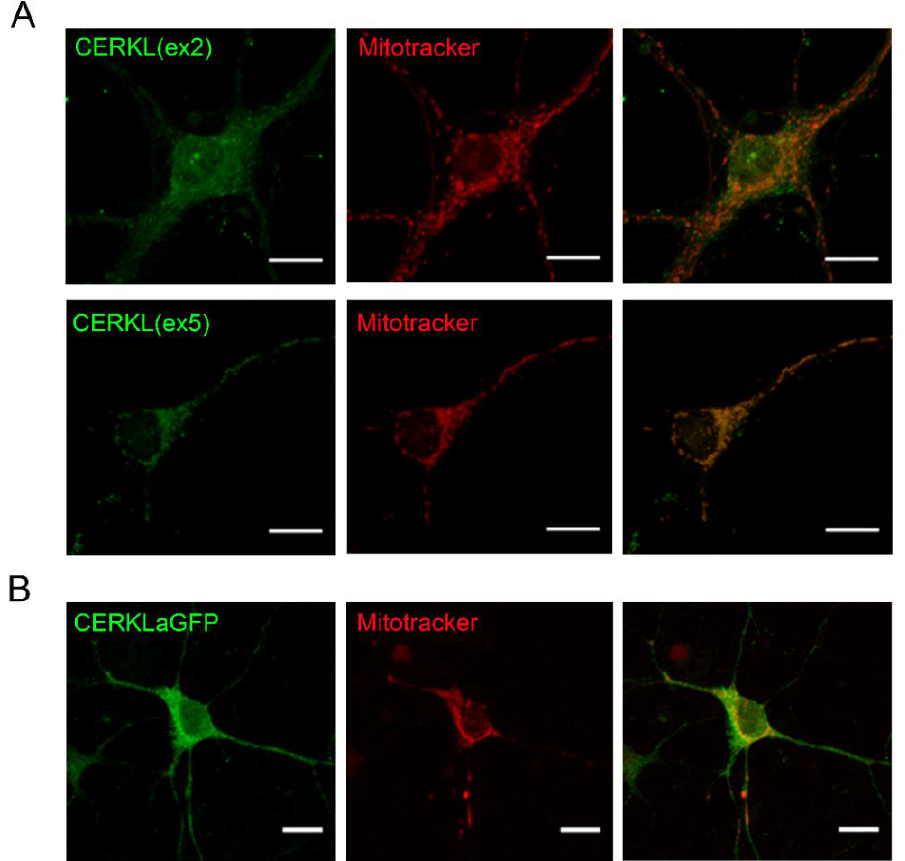
Figure 1. CERKL is expressed in primary hippocampal neurons and partially localizes at mitochondria. ( A ) CERKL is detected in primary hippocampal neurons (E16) by immunostaining with antibodies CERKL(ex2) or CERKL(ex5) (green). Mitotracker (red) is used to stain mitochondria. Note that CERKL isoforms containing exon 5 (detected with CERKL(ex5)) show higher localization at mitochondria. ( B ) Overexpression of CERKLa-GFP in primary hippocampal neurons shows partial localization of CERKLa (green) at mitochondria, which are stained with Mitotracker (red). Scale bars: 10 μm.